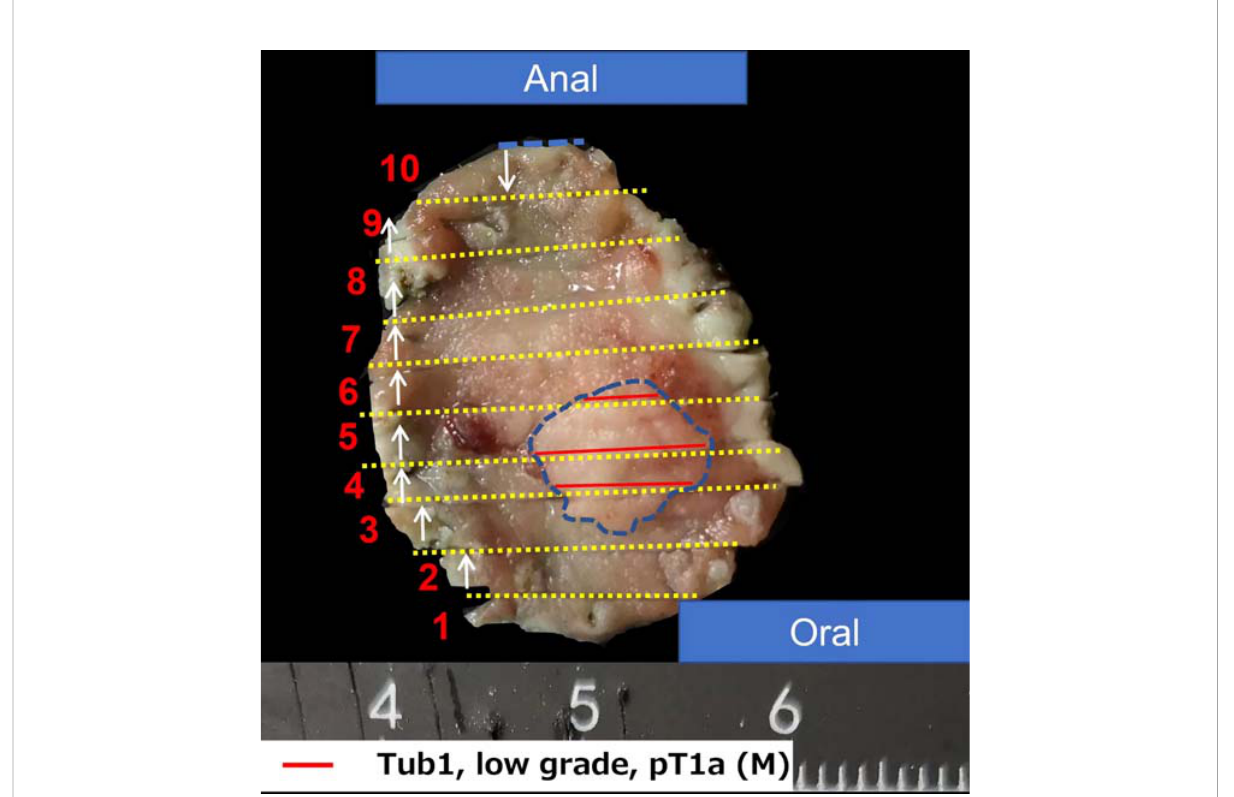
FIGURE 4 Pathological recovery diagrams. New subtype of gastric adenocarcinoma arising from an H. pylori -uninfected stomach: foveolar epithelium and mucous neck cell-mixed type adenocarcinoma, pT1a (M), Ly0, V0, pUL0, pHM0, and pVM0. The specimen was 2 × 2.5 cm and type 0-IIa, and the cancerous lesion was 7 × 5 mm with red marking in the blue